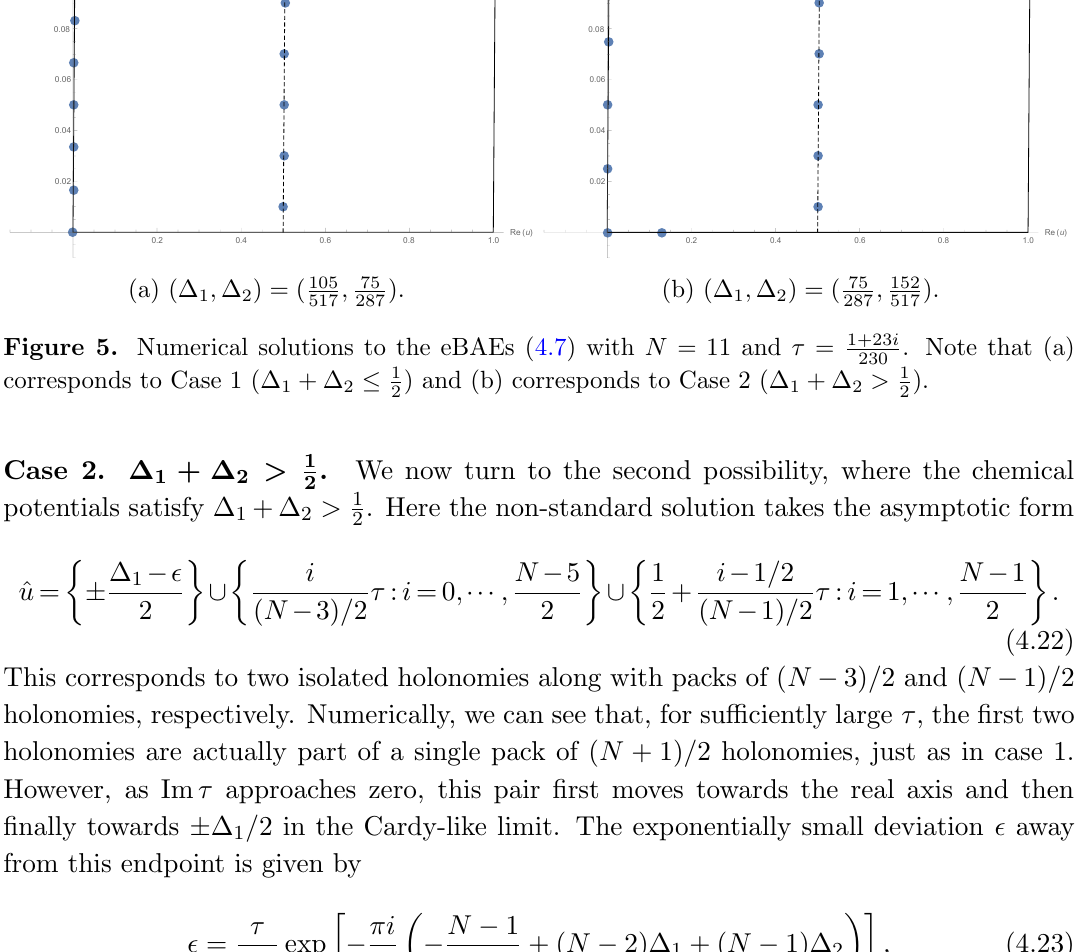
) and (b) corresponds to Case 2 ((cid:1) 1 + (cid:1) 2 > 1 2